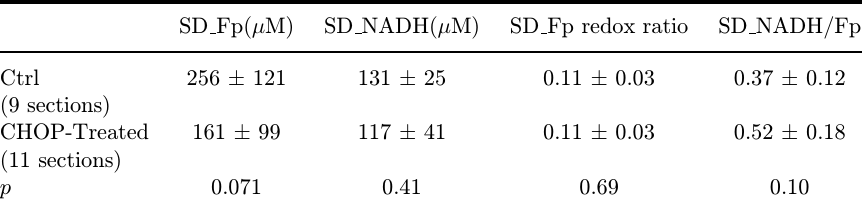
Table 3. Mean values of the standard deviations of the redox indices (cid:3)